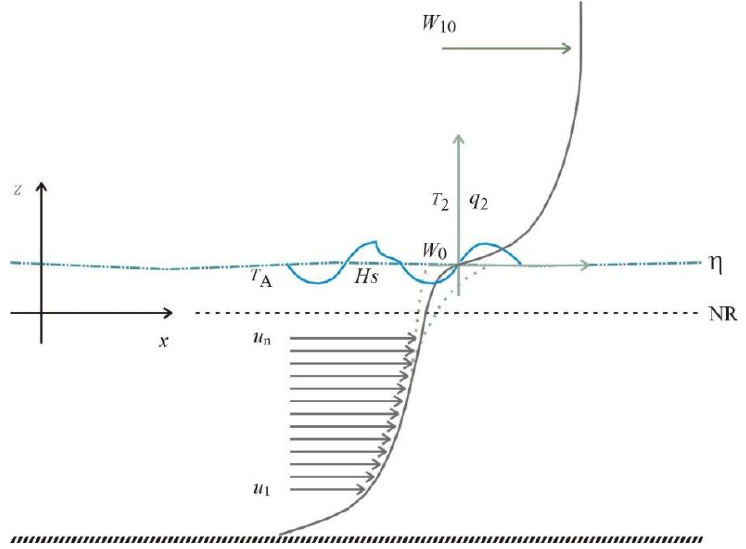
Figure 1. Combined profiles of currents and winds obtained from equations iteratively solved with the measured data.